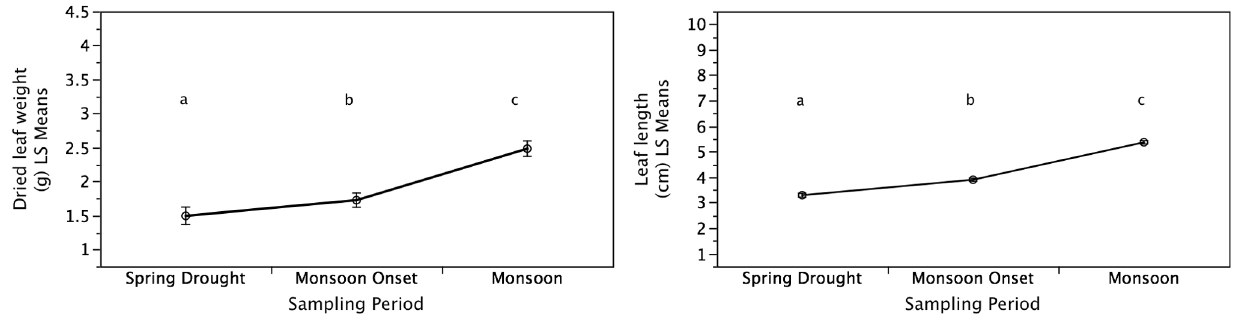
Figure 2. Effects of Precipitation Variability on Tea Growth. Increased precipitation from the spring drought to the monsoon tea harvest significantly increased tea leaf weight and length. Sampling periods not connected by the same letters are significantly different. Values are means 6 one standard error.